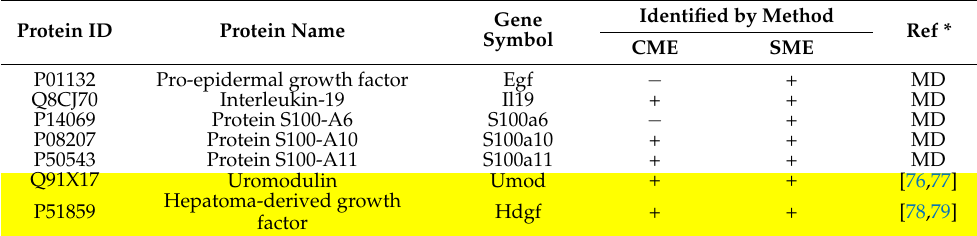
Table A6. The list of matrisome-associated proteins belonging to the category of secreted factors and identified in at least two of the biological replicates. Rows highlighted in yellow describe identified matrisome proteins which were not previously listed in the